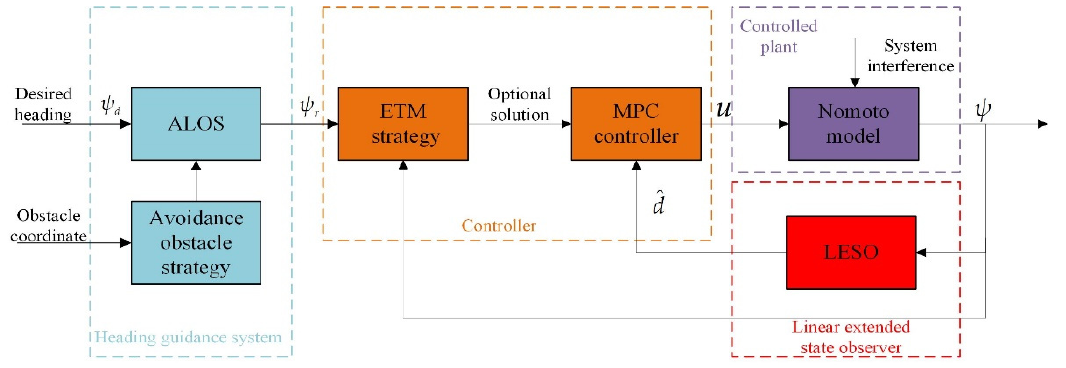
Figure 1. Structure description of the whole USV system.